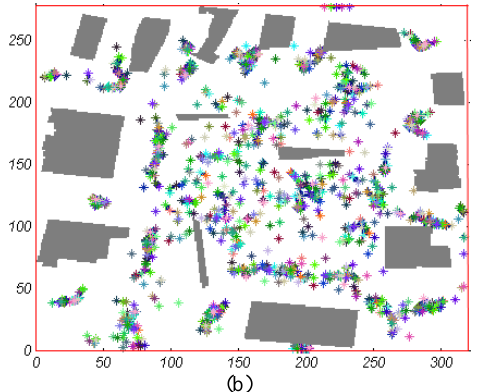
Figure 6. The sample 3D raster environment